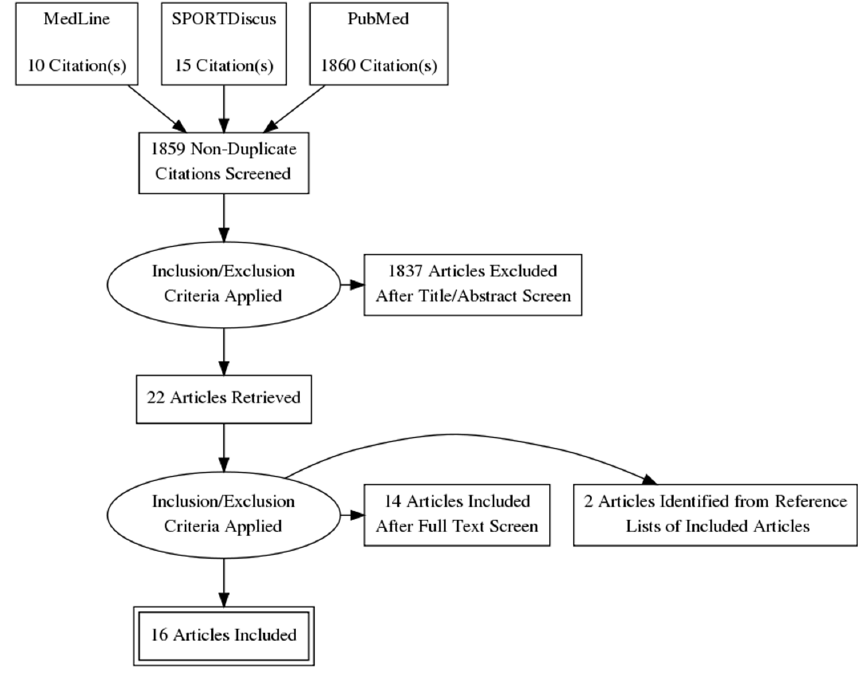
Figure 1. PRISMA diagram: flow chart of study selection process. Table 1. Studies investigating the effects of omega-3 supplementation on measures of muscular health in older adults.